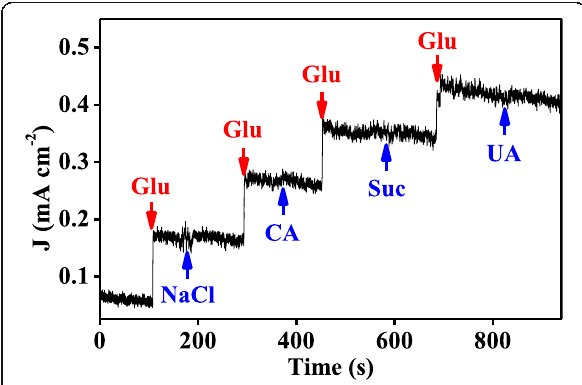
Fig. 6 The current density responsing curves of the present Ni 6 /AB composites for the alternately addition of glucose (glu, 0.15 mM), NaCl (0.15 mM), CA (0.15 mM), Suc (0.025 mM), and UA (0.025 mM)